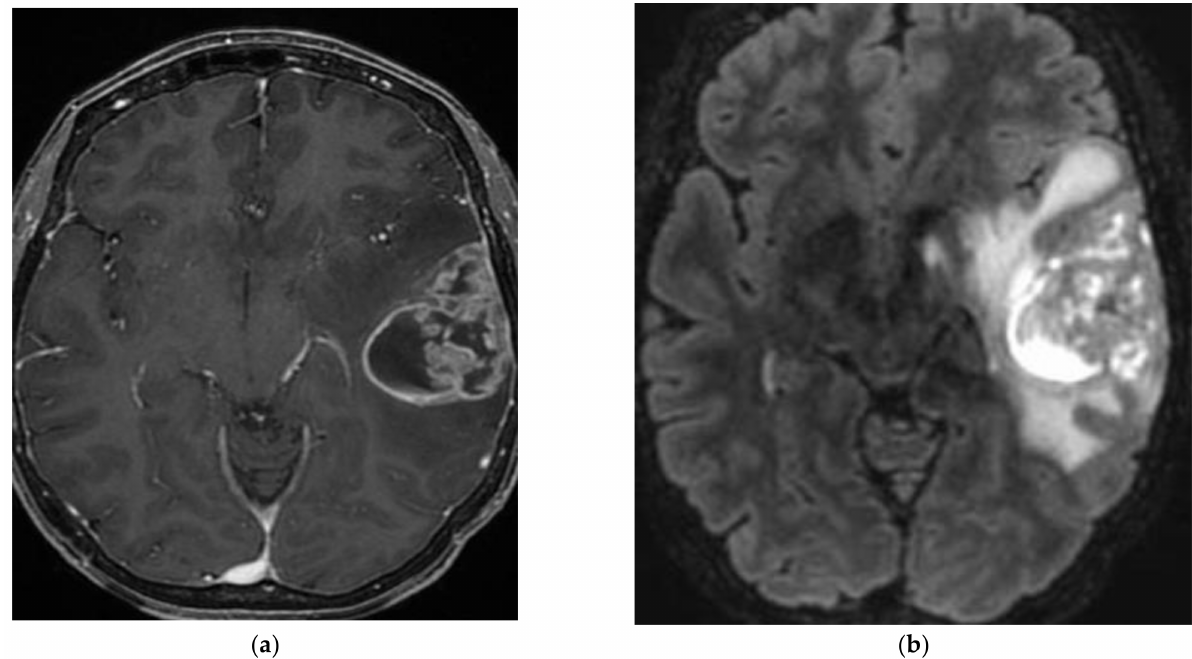
Figure 6. A 44-year-old female with left temporal astroblastoma diagnosed on an MRI after multiple seizures. After total resection, the patient received radiotherapy. ( a ) T1-weighted image after gadolinium infusion; ( b ) Flair-weighted